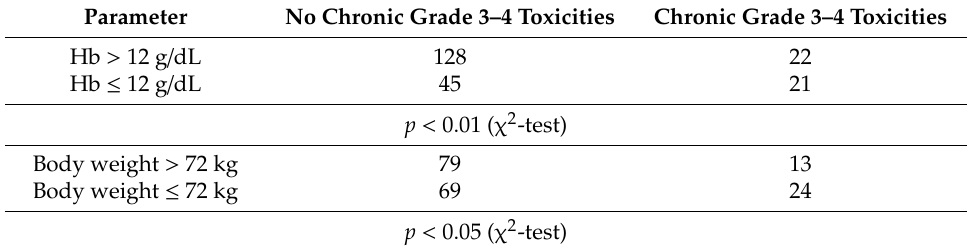
Figure 6. Box-plot diagram showing various baseline blood parameters, namely hemoglobin ( A ), leukocyte count ( B ), albumin ( C ), LDH ( D ), CRP ( E ), GFR ( F ), creatinine ( G ), and body weight ( H ) in dependence of acute or chronic CTCAE grade 3–4 toxicities. The box extends from the first to the third quartile, while the horizontal line shows the median sample value. The whiskers range from the 5th percentile to the 95th percentile, and all other points are plotted as outliers. Two-sided unpaired t -tests were performed for comparisons. * p < 0.05. Table 4. Cross table showing the number of elderly HNSCC patients who experienced chronic grade 3–4 toxicities in dependence of the baseline hemoglobin (Hb) value and body weight. Groups were compared using χ 2 -tests.